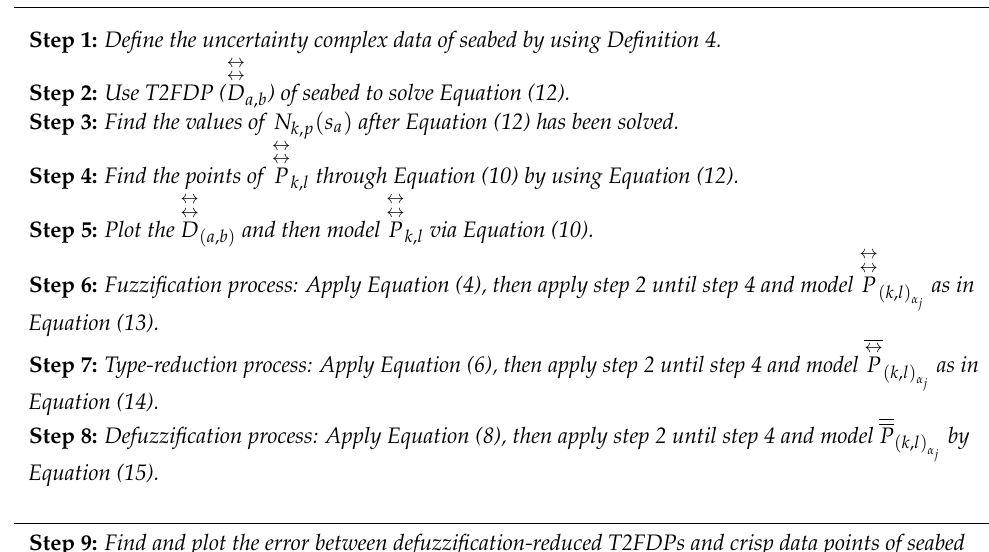
Algorithm 1. Modeling T2FDP using interpolation type-2 B-spline